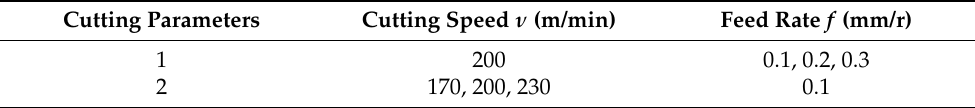
Table 5. Selection of Test Cutting Parameters.